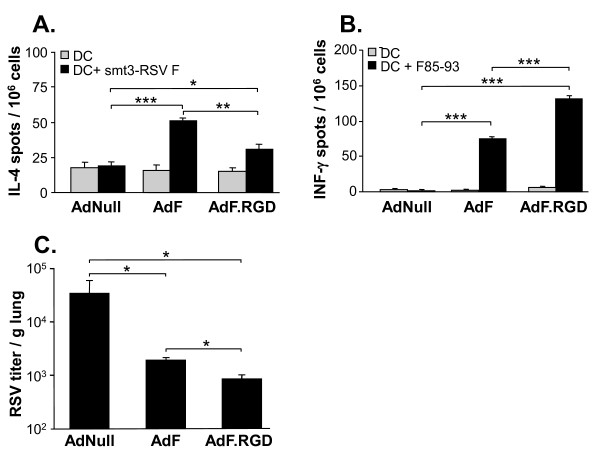
Frequency of RSV F protein-specific Th2-type CD4 and CD8 T cells and immunity against RSV in BALB/c mice following intramuscular immunization with AdF or AdF.RGD (1010 pu/mouse). A, B. Ten days following immunization, spleen CD4 and CD8 T cells were co-cultured with splenic DC alone or with DC pulsed with recombinant smt3-RSV F protein or F peptide (DC-smt3-RSV F; DC-F85-93, respectively) and RSV F-specific cytokine responses were measured after 48 h by ELISPOT assay. A. RSV-specific IL-4 production in CD4 T cells; B. F epitope-specific production in CD8 T cells. C. RSV titer in the lungs of mice challenged by intranasal administration of RSV (106 cfu) 4 wk after immunization. Data represent mean ± SD of 5 animals/group from one of two independent experiments. ***, ** and * denote significance of p < 0.001, p < 0.01 and p < 0.05, respectively.